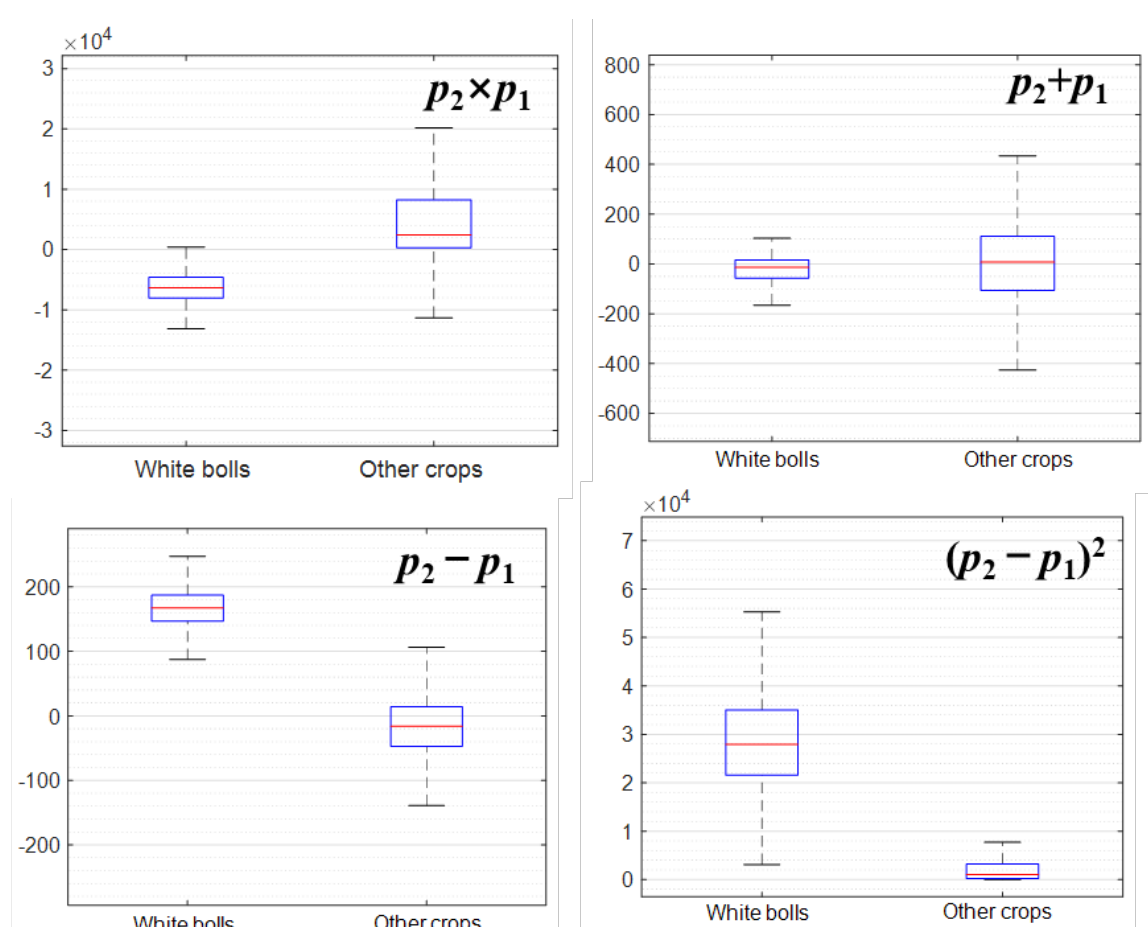
Figure 7. The value distribution for white bolls and other crops with four combinations of linear discriminant analysis (LDA) components. p 2 × p 1 , p 2 + p 1 , p 2 − p 1 , ( p 2 − p 1 )